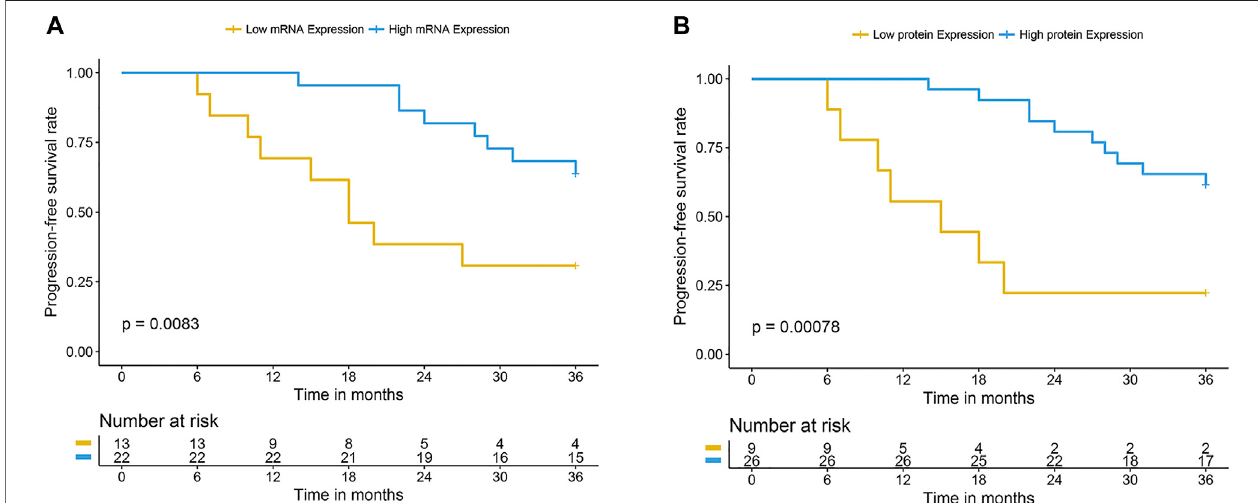
FIGURE 5 | PFS of patients with high and low expression of OCTN2 with negative lymph nodes treated with oxaliplatin. Kaplan -Meier progression-free survival curves in lymph node negative patients with low or high mRNA (A) or protein (B) expression of OCTN2. Samples with relative mRNA value or staining score ≥ of the median value were classi fi ed as OCTN2 high-expressing